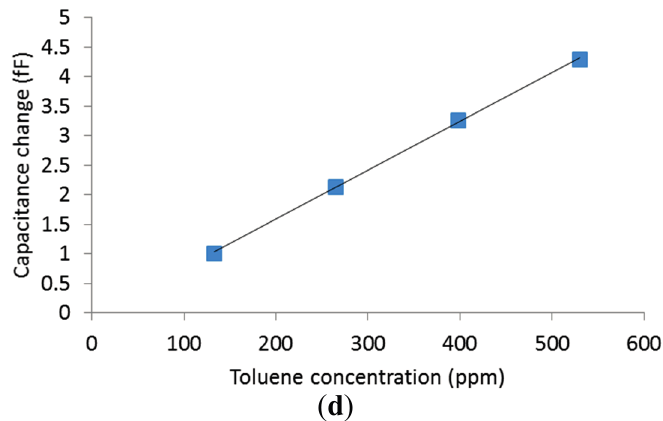
Figure 11. MOF response (change in capacitance) for different concentrations of ( a ) acetone, ( b ) ethanol, ( c ) methanol and ( d ) toluene. The baseline capacitance is approximately 4.4 pF. Measurements were done at a temperature of 22